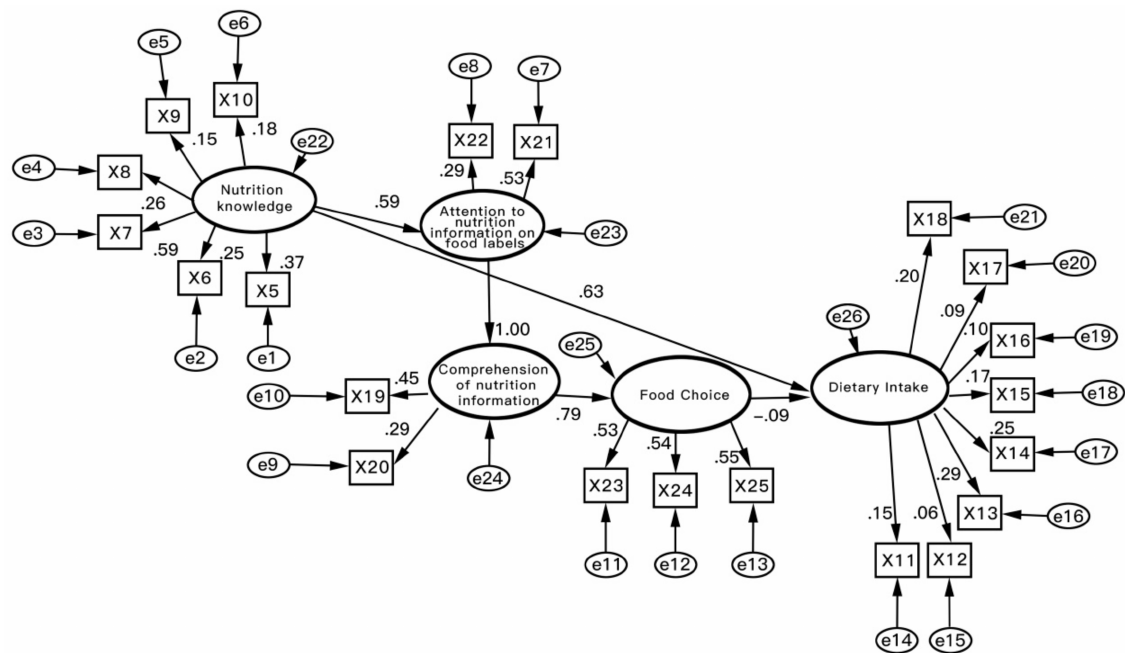
Figure 2. Results of Structural Equation Modeling. Notes: Comparative Fit Index = 0.932; Goodness-of-fit Index = 0.931; Root Mean Square Error of Approximation = 0.059; Degrees of freedom = 184; chi-square = 203.20; x5~x25 is the scale items code and e1~e26 is statistical error of 5 variables and 21 scale